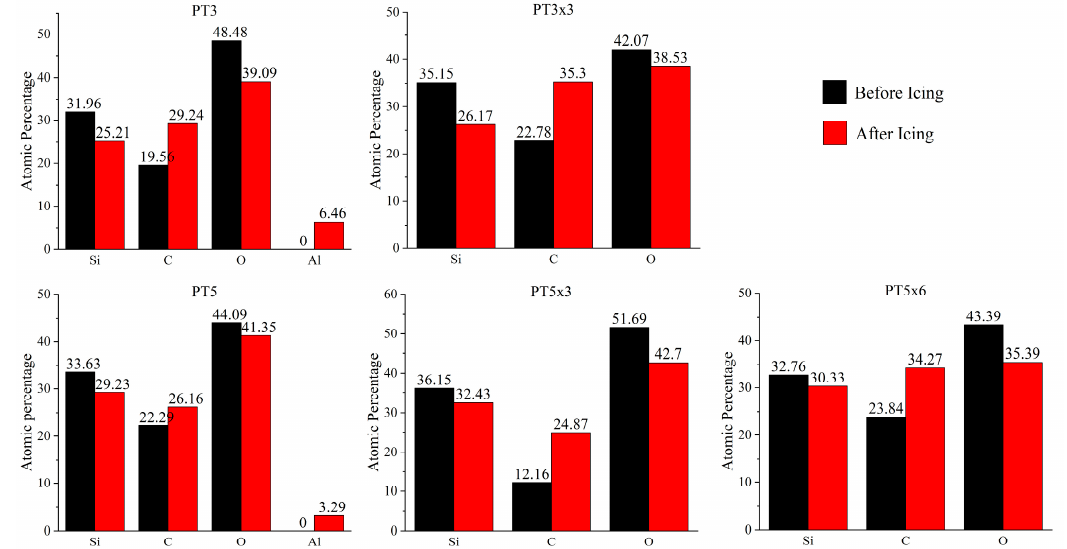
Figure 11. Atomic percentages of silicon, carbon, aluminum and oxygen on all coatings derived from XPS.